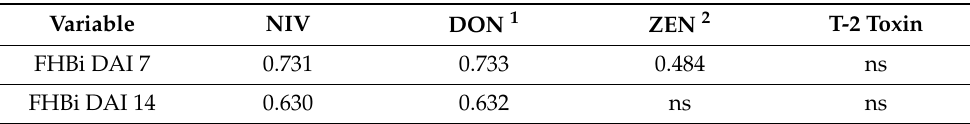
Table 6. Pearson’s coefficients of linear correlation ( p < 0.05) between Fusarium head blight index (FHBi) evaluated 7 and 14 days after the inoculation (DAI 7 and DAI 14) and mycotoxin content in the